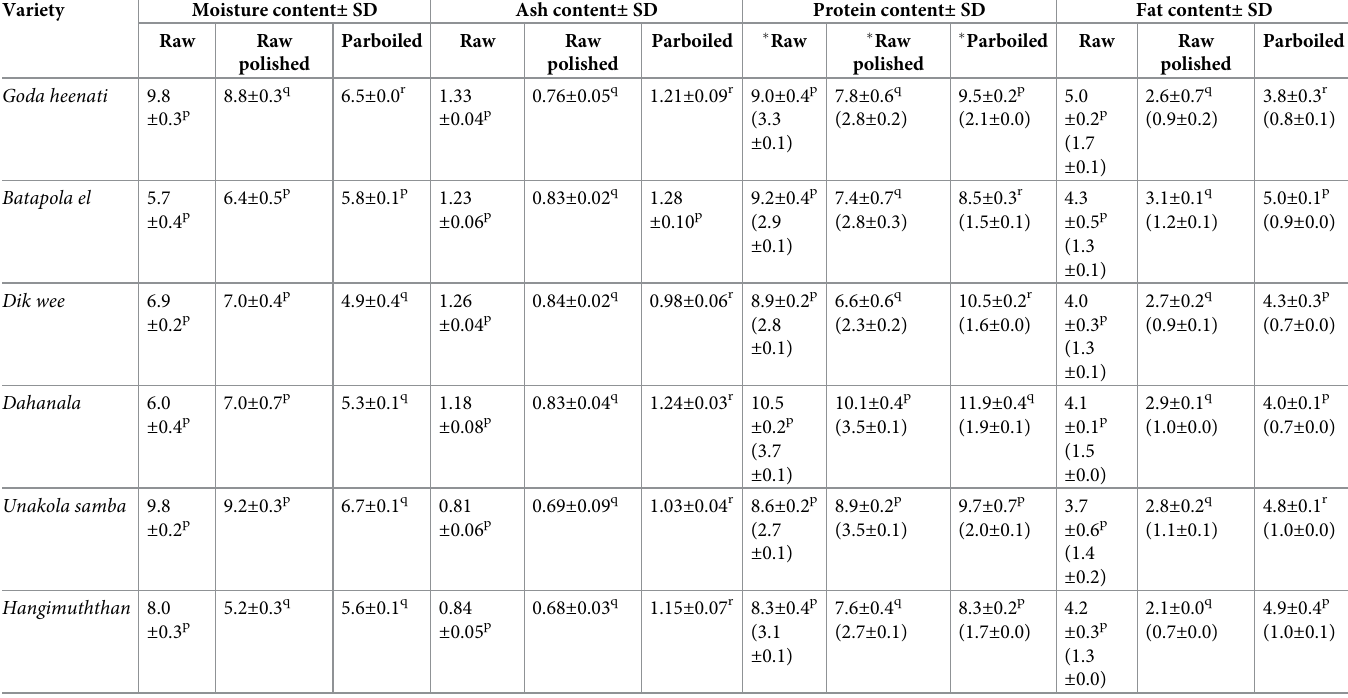
n = 5; � n = 3; SD: Standard Deviation; p, q and r superscripts along a row in each parameter (Moisture, Ash, Protein and Fat) indicate significances among differently processed rice varieties at 95% confidence